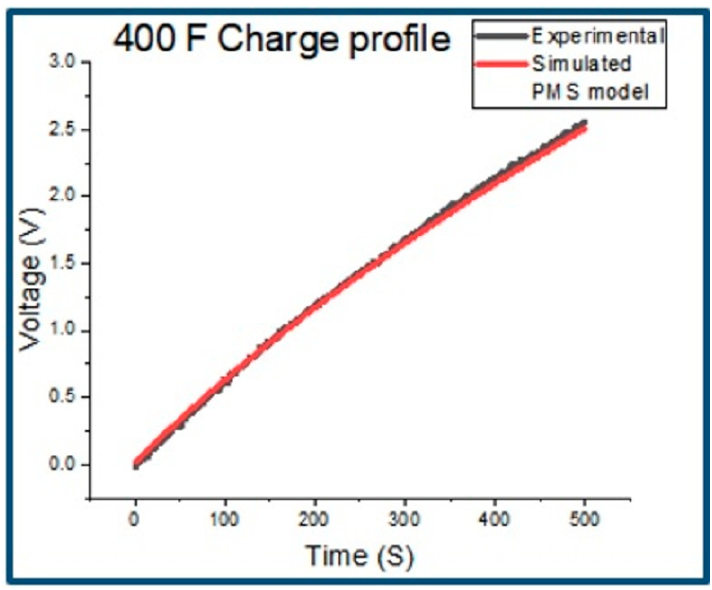
Figure 10. The 400 F EDLC superimposed experimental/PMS-charge